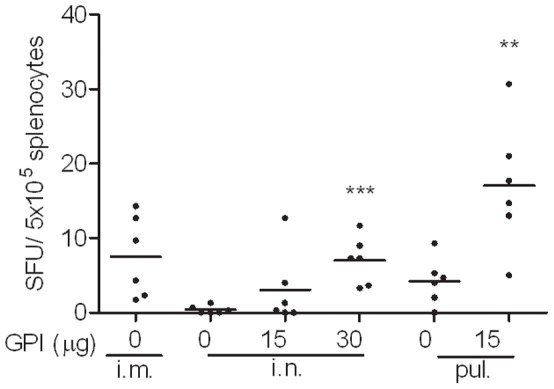
Effect of GPI-0100 on influenza-specific IL-4-producing T cells.Mice were immunized on day 0 and on day 20 with 1 µg A/PR/8 subunit vaccine alone or adjuvanted with the indicated doses of GPI-0100. The immunizations were given via intramuscular (i.m.), intranasal (i.n.) or intrapulmonary (pul.) route. Spleen samples were collected one week later upon termination. Splenocytes were isolated and stimulated overnight with PR8 subunit. The result is expressed as cytokine producing splenocytes per 5×105 cells of individual mice.